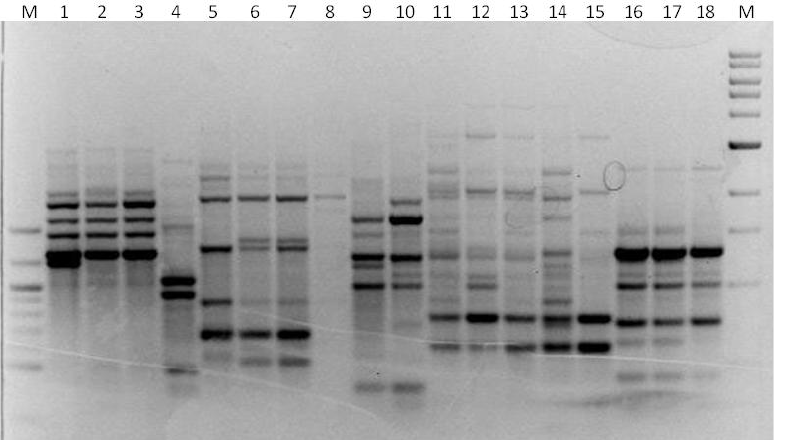
Figure 1. Representative agarose gel showing RAPD profiles generated with the primer (GTG)3. M: 100 bp DNA marker; 1: S. bacillaris Sb N11; 2: S. bacillaris Sb P51; 3: S. bacillaris Y-14; 4: S. bacillaris